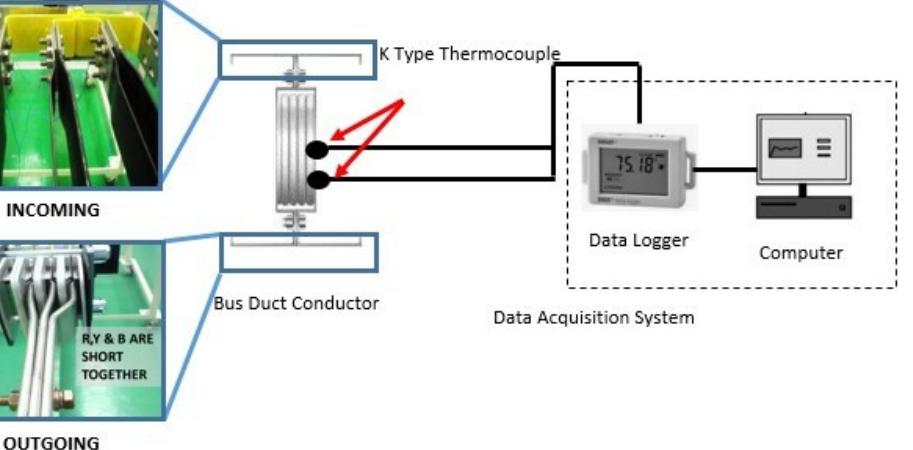
Coatings 2023 , 13 , x FOR PEER REVIEW